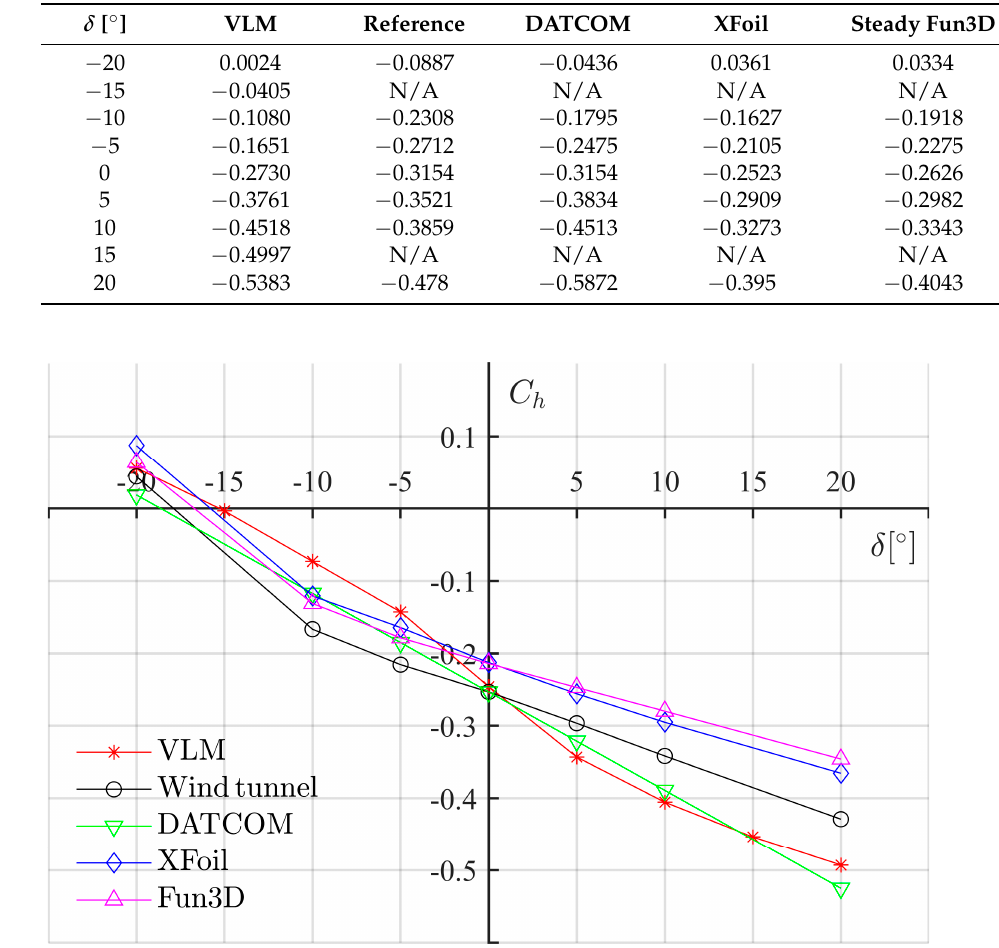
C versus δ for GA(W)-1 at alpha 12°. Figure A4. Figure A4. C h versus δ for GA(W)-1 at alpha 12 ◦ h C for GA(W)-1 at alpha 12°. h